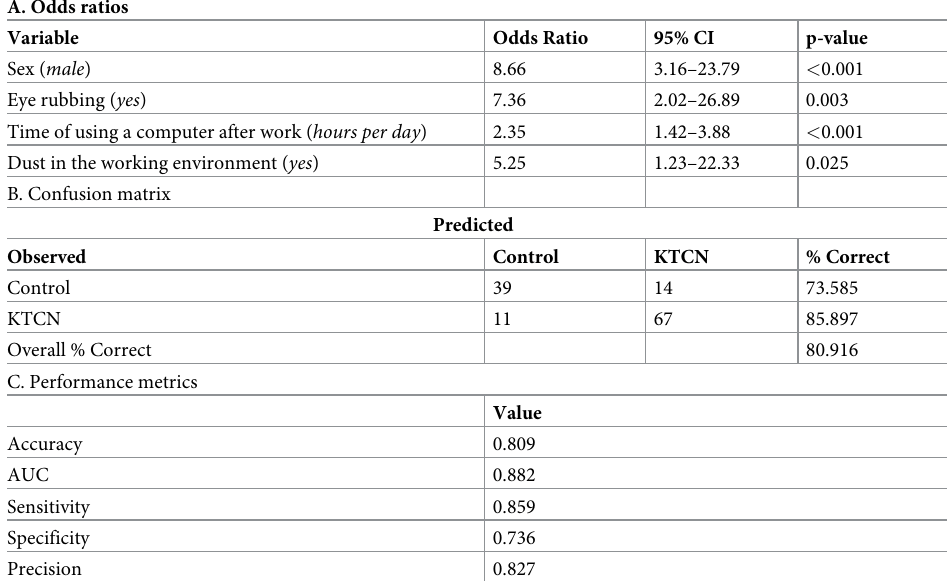
Table 5. Substantial KTCN risk factors, odds ratios, the confusion matrix, and performance metrics in a multivar- iate